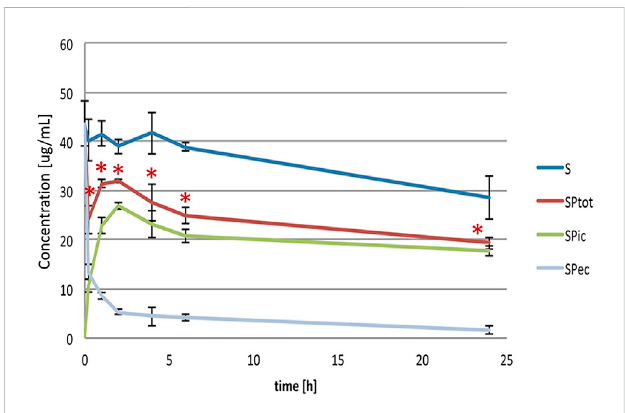
FIGURE 1 Extracellular, intracellular and total simvastatin level over the 24-h incubation with (SP ec , SP ic , SP tot ) and without probiotic bacteria (S). Statisticallysigni fi cantdifferenceoftotalsimvastatinlevel,calculatedasa sum of intracellular and extracellular amount, was noted versus control, without probiotic bacteria, during the entire study period (* p <